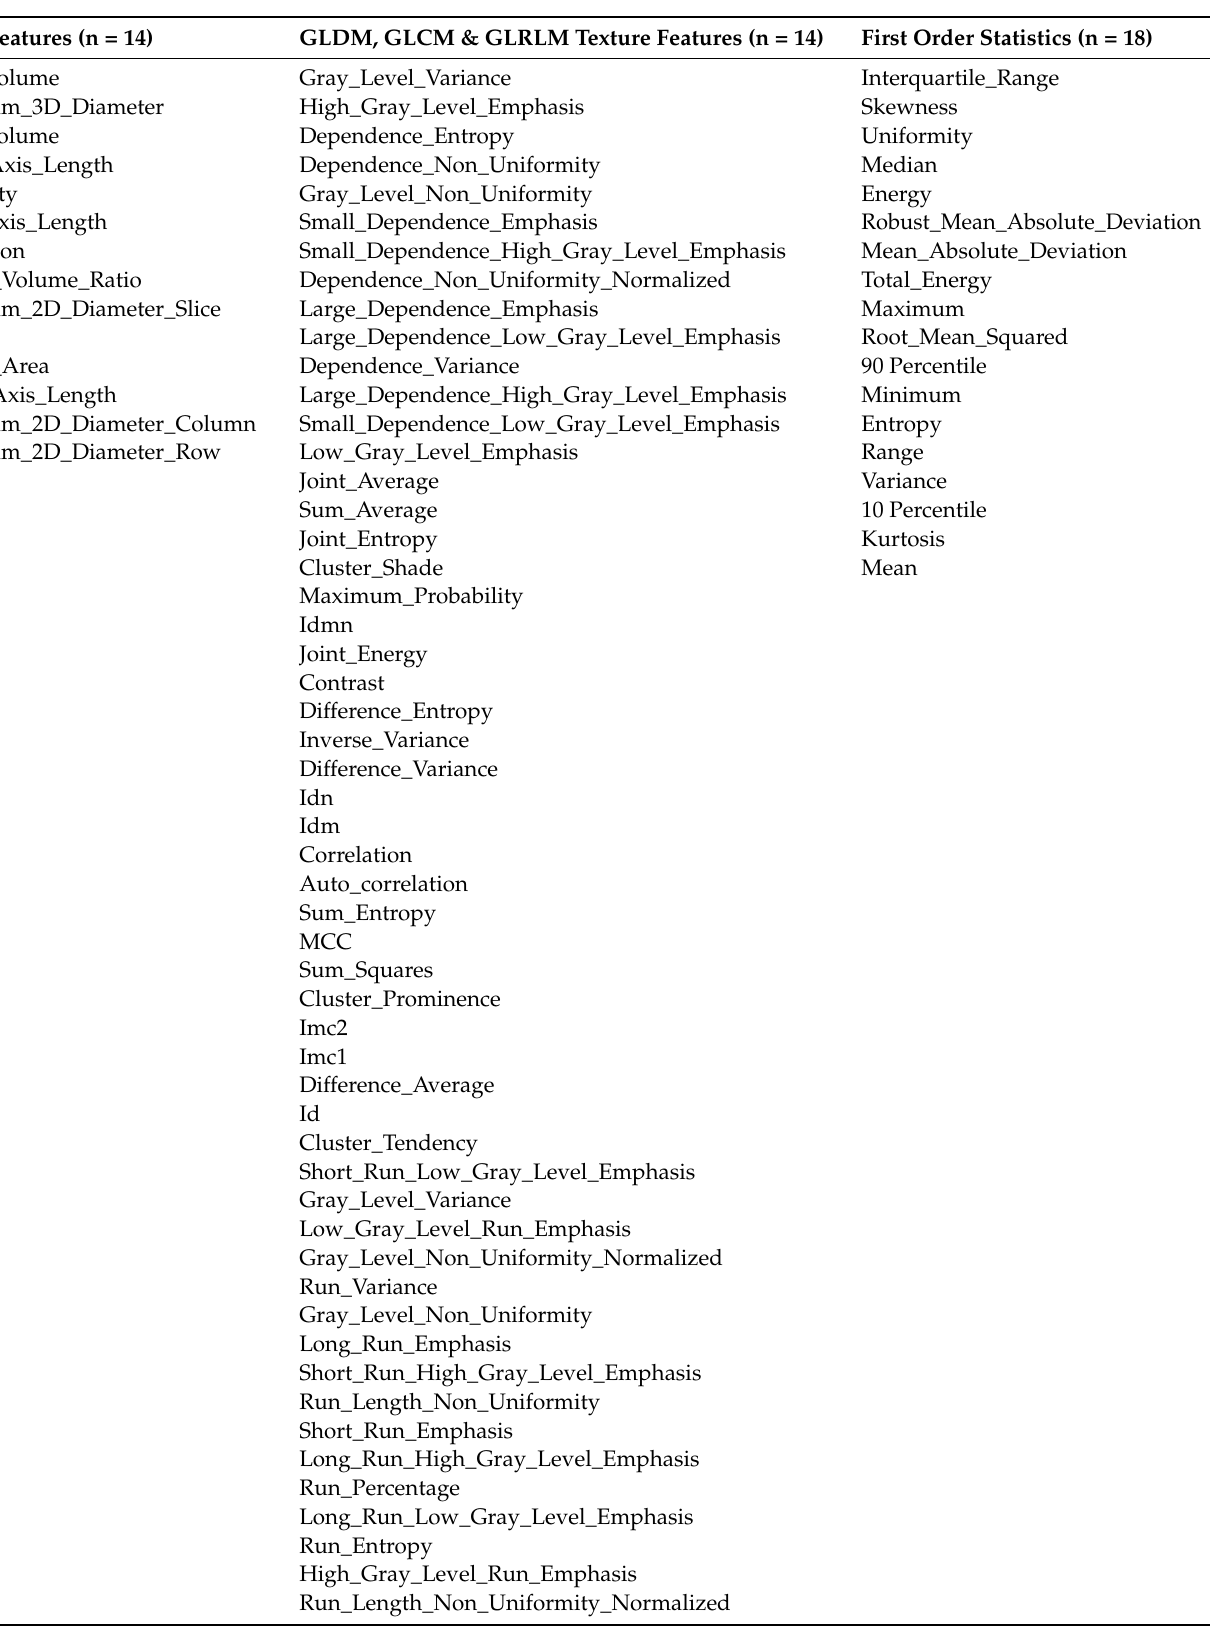
Table 1. 86 radiomic characteristics were utilising using a